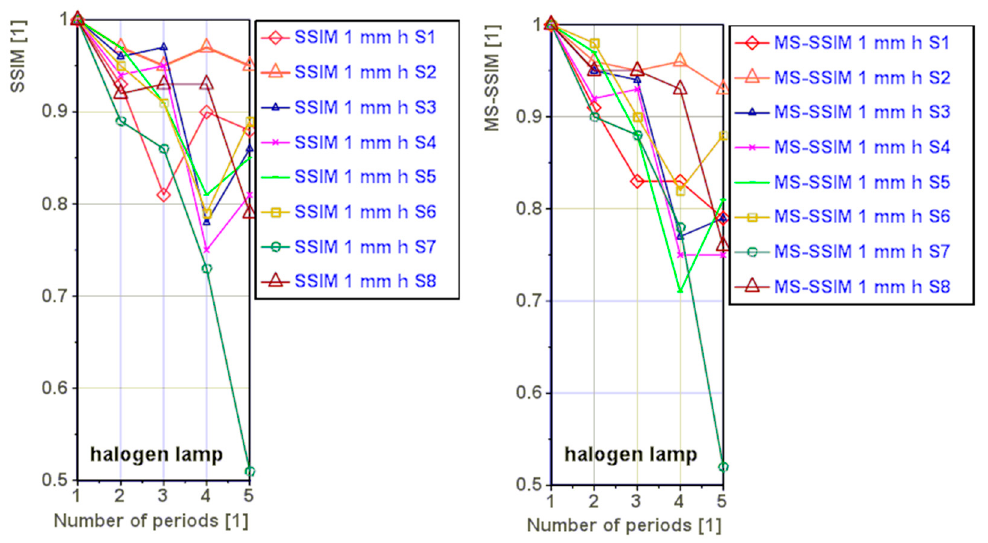
Figure 8. Variation of the SSIM and MS-SSIM index values as a function of the number of periods for the halogen lamp.